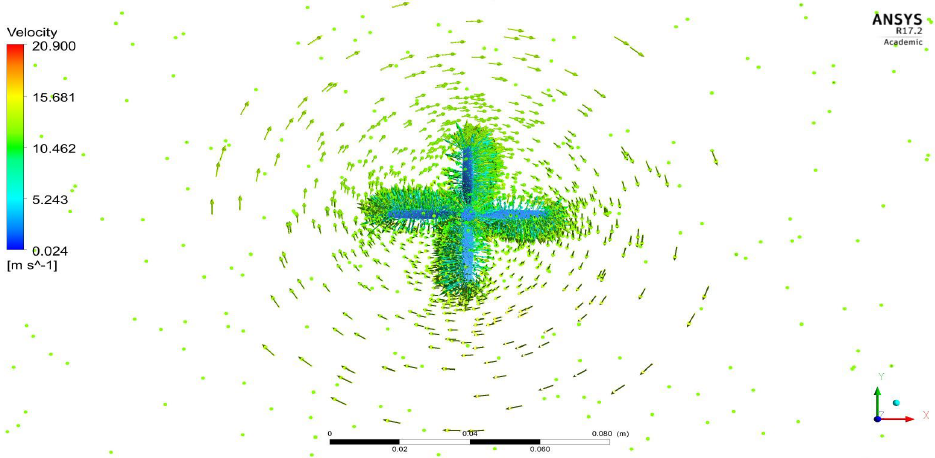
Figure 51. Hydrodynamic velocity variations on the UAV propeller under 800 RPM with wave celerity of 12.10 m/s.